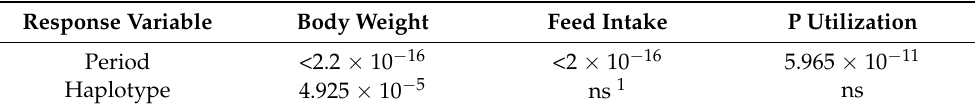
Table A1. Influence of period and haplotype on body weight, feed intake and phosphorus utilization. p -values are from the evaluation of the statistical model using a three factorial anova.